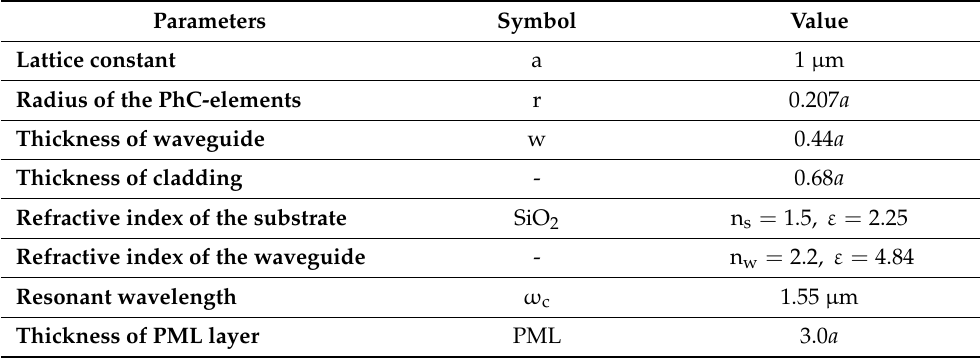
Table 1. Optimized design parameters of the proposed optical switching device.